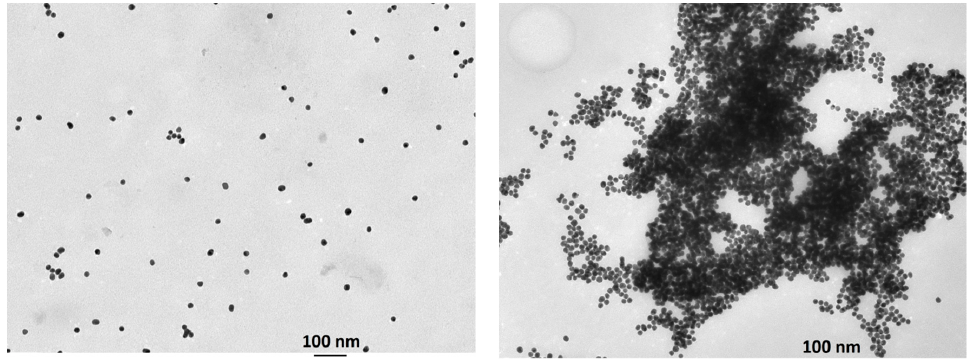
Figure 3. TEM images of stabilized AuNP-1 dispersion (left) and their aggregates upon addition of excess of H 2 CO (right).